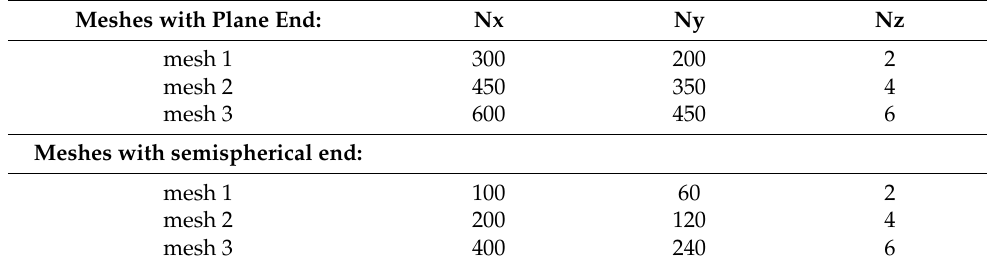
Table 1. The mesh model parameters. Meshes with Plane End: Nx